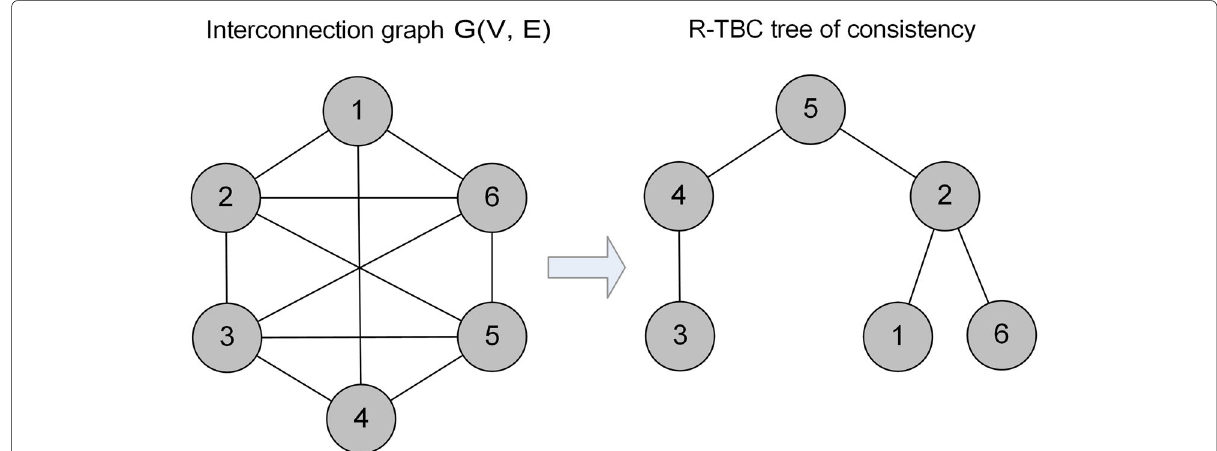
Fig. 12 Initial interconnection graph of highly-distributed system and final R-TBC consistency tree with the application of advanced RTA Rose Tree Algorithm